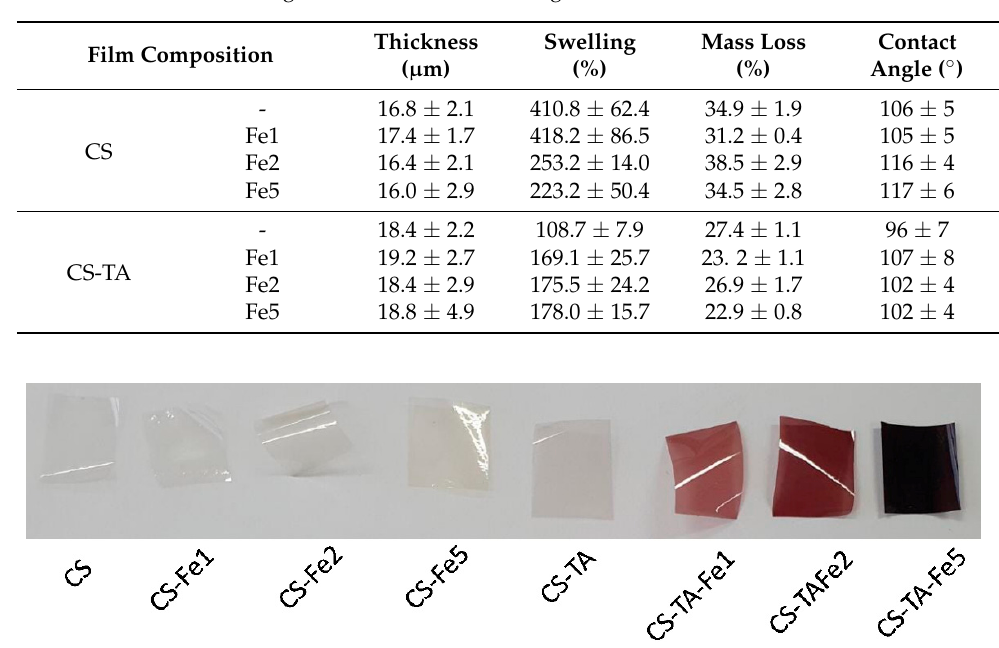
Figure 1. Visual aspect of the chitosan/gentamicin films crosslinked with tannic acid (TA) and iron (Fe). Table 2. Thickness, swelling, mass loss and contact angle of the films.